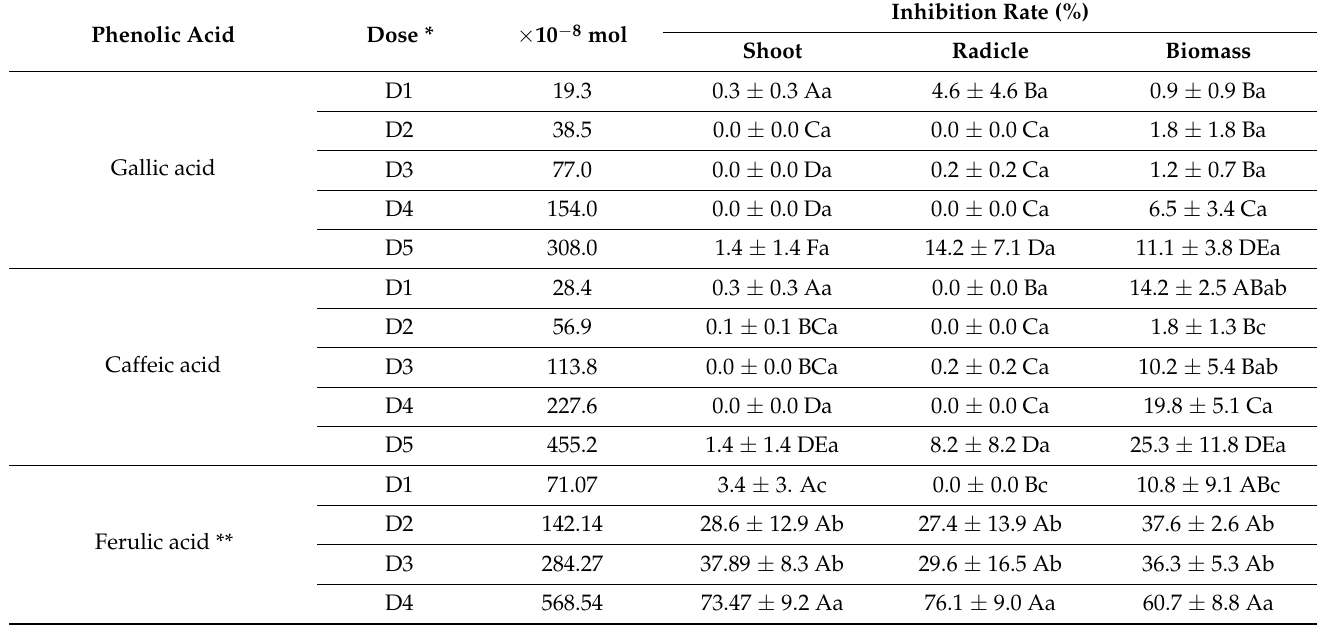
Table 1. Inhibition of the early growth of Ambrosia artemisiifolia by phenolic acids at different dose